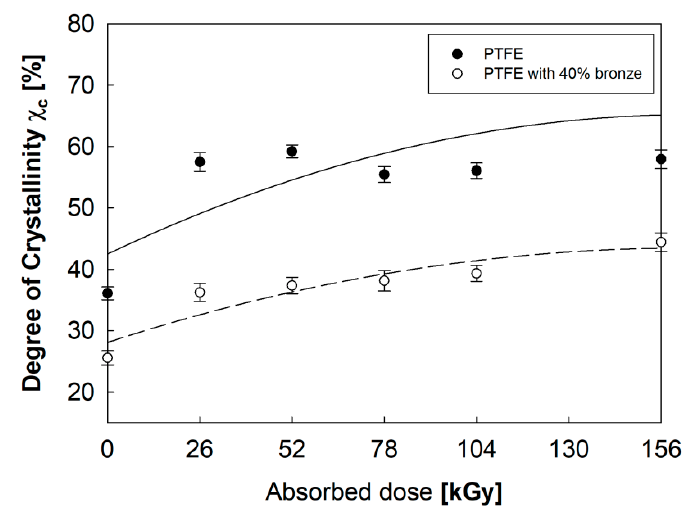
Figure 4. Degrees of crystallinity, χ c of PTFE and PTFE with a 40% addition of bronze in their initial states and after electron beam irradiation.